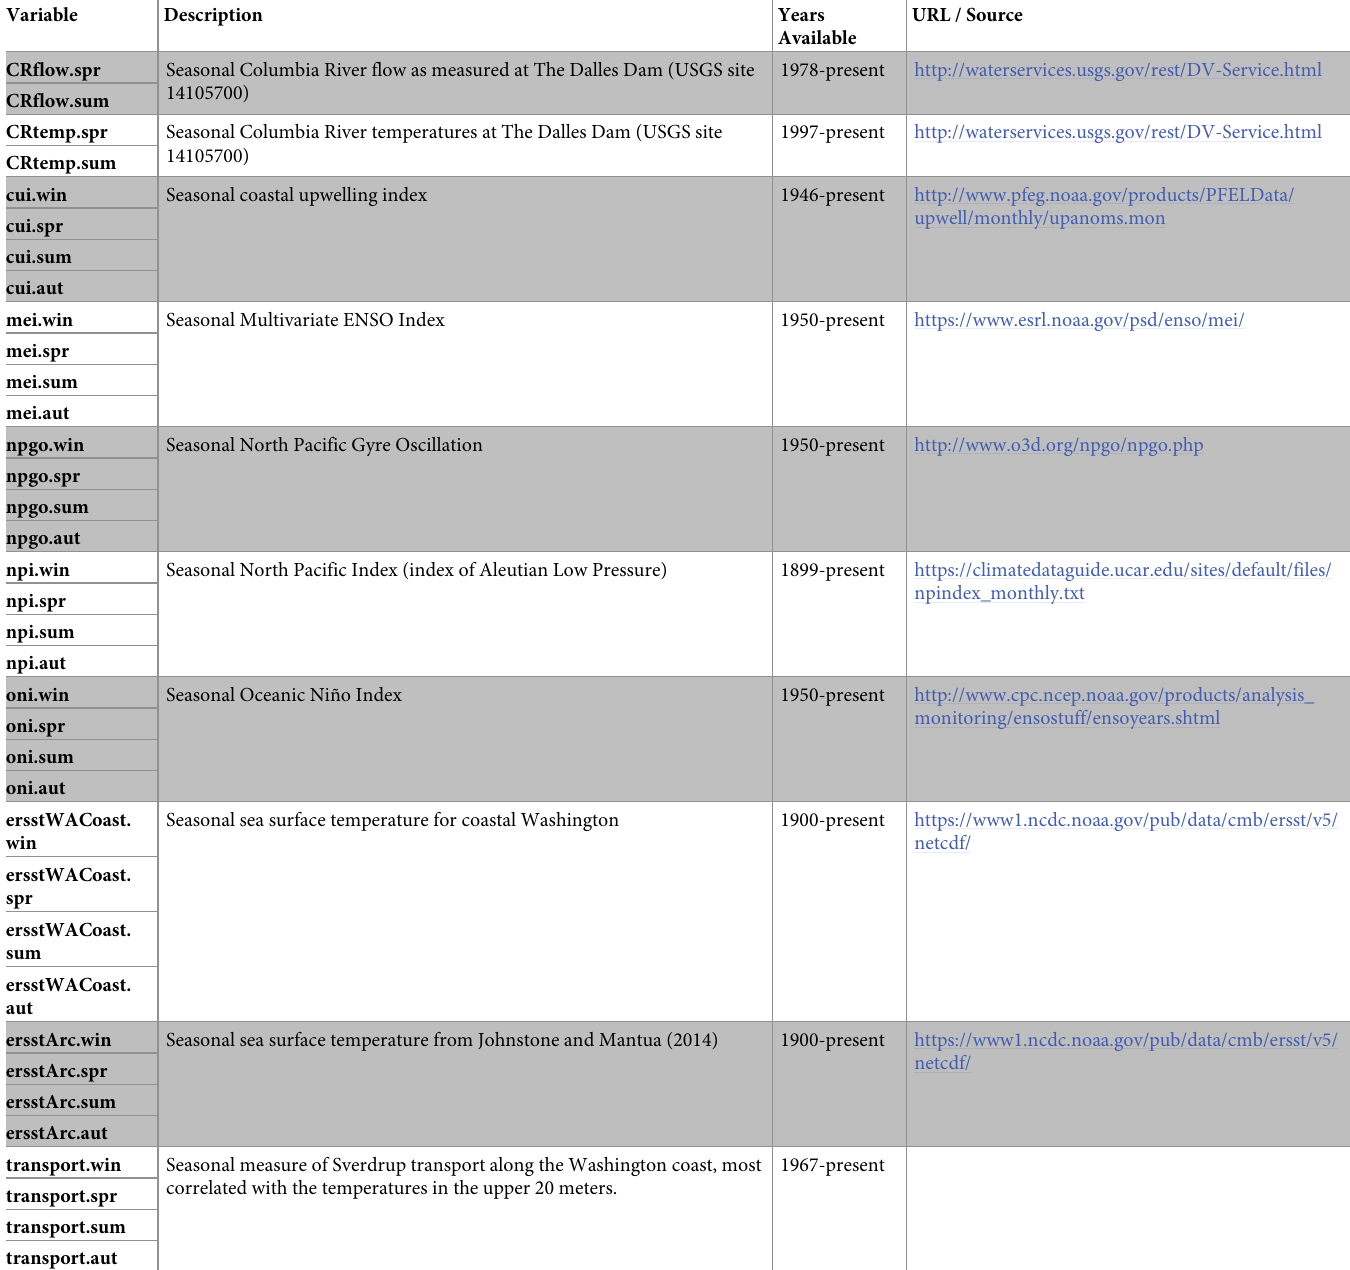
Table 2. Description of model